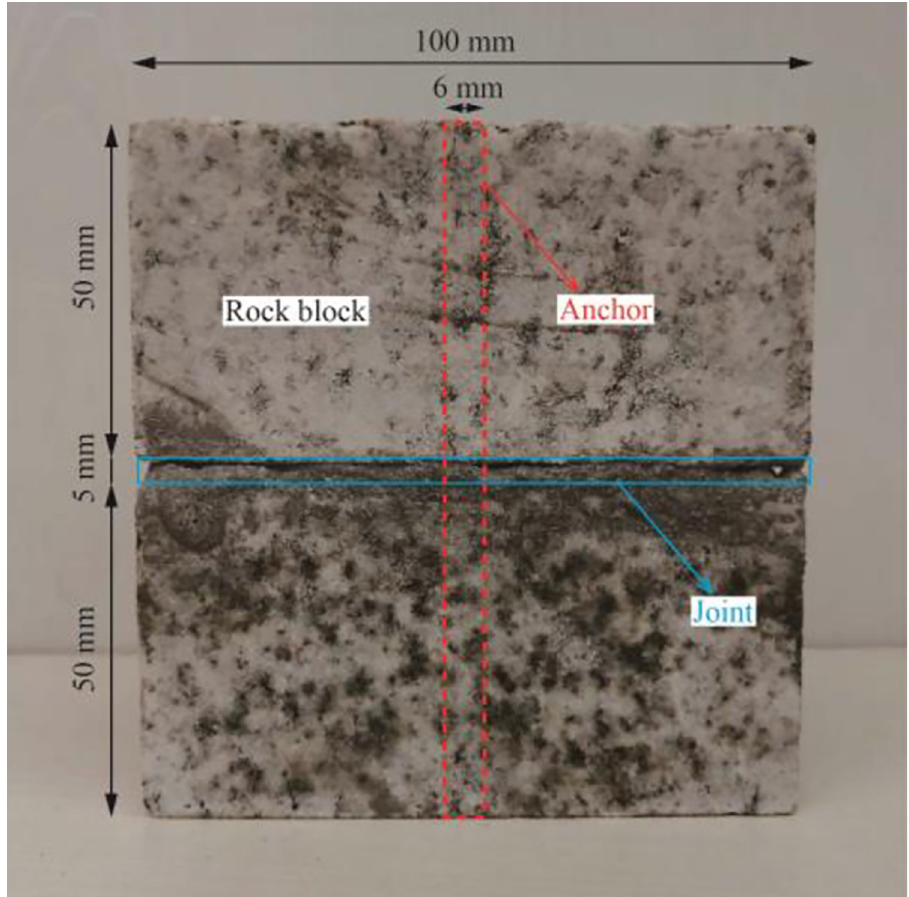
Fig 1. Schematic diagram of the anchorage rock mass.